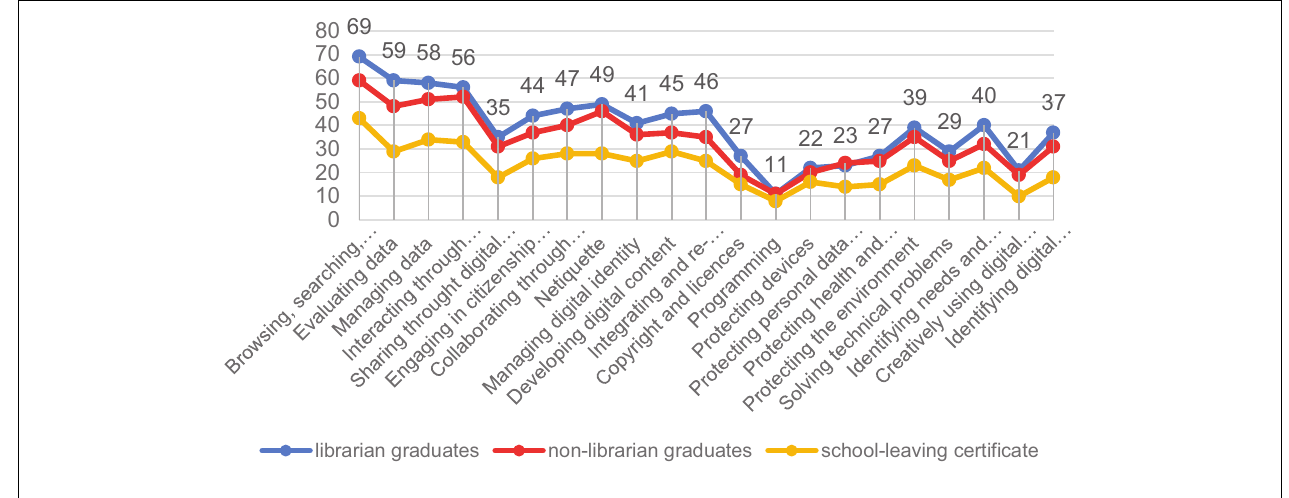
FIGURE 2 | Advanced and highly specialized level by education.